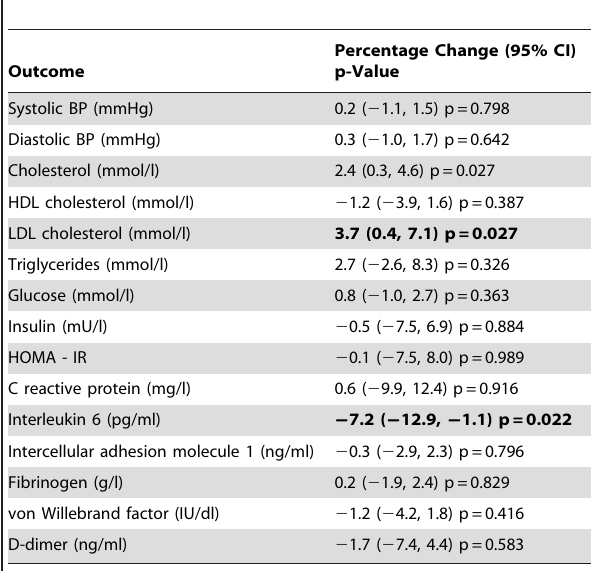
Table 2. Highlights the percentage change in biomarker levels that is associated with an increase in telomere length.